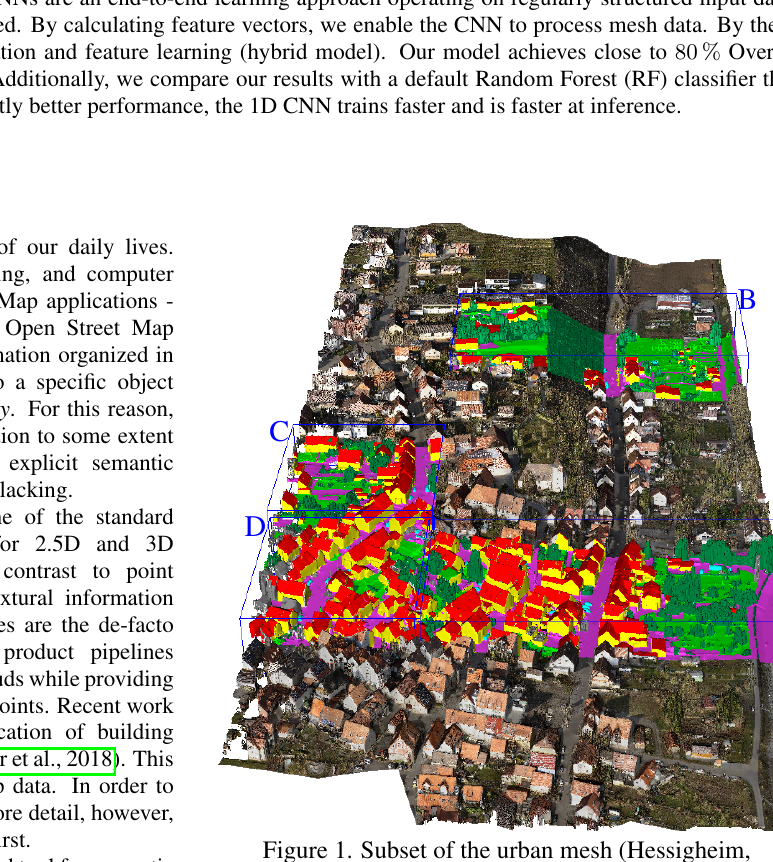
Figure 1. Subset of the urban mesh (Hessigheim, Germany). The blue bounding boxes depict tiles A, B, C, and D that are used for validation and testing (mutually exclusive), represented semantically labeled here. The following class color code and enumeration is used throughout the paper: 1. building mass/facade (yellow), 2. roof (red), 3. impervious surface (magenta), 4. green space (light green), 5. mid and high vegetation (dark green), 6. vehicle (cyan), 7. chimney/antenna (orange) and 8. clutter (gray). Remaining tiles are used for